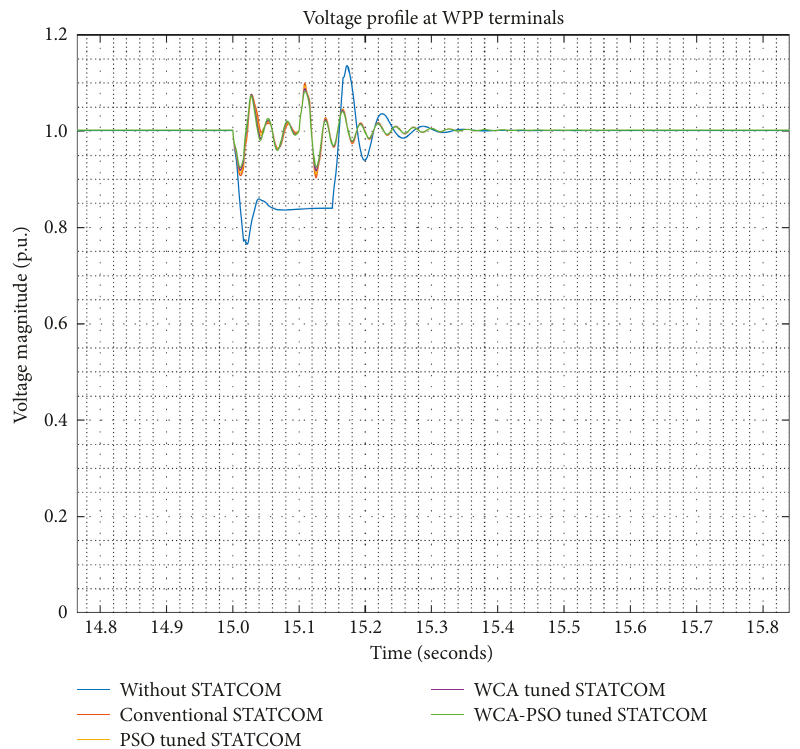
Figure 11: Voltage profile at WPP